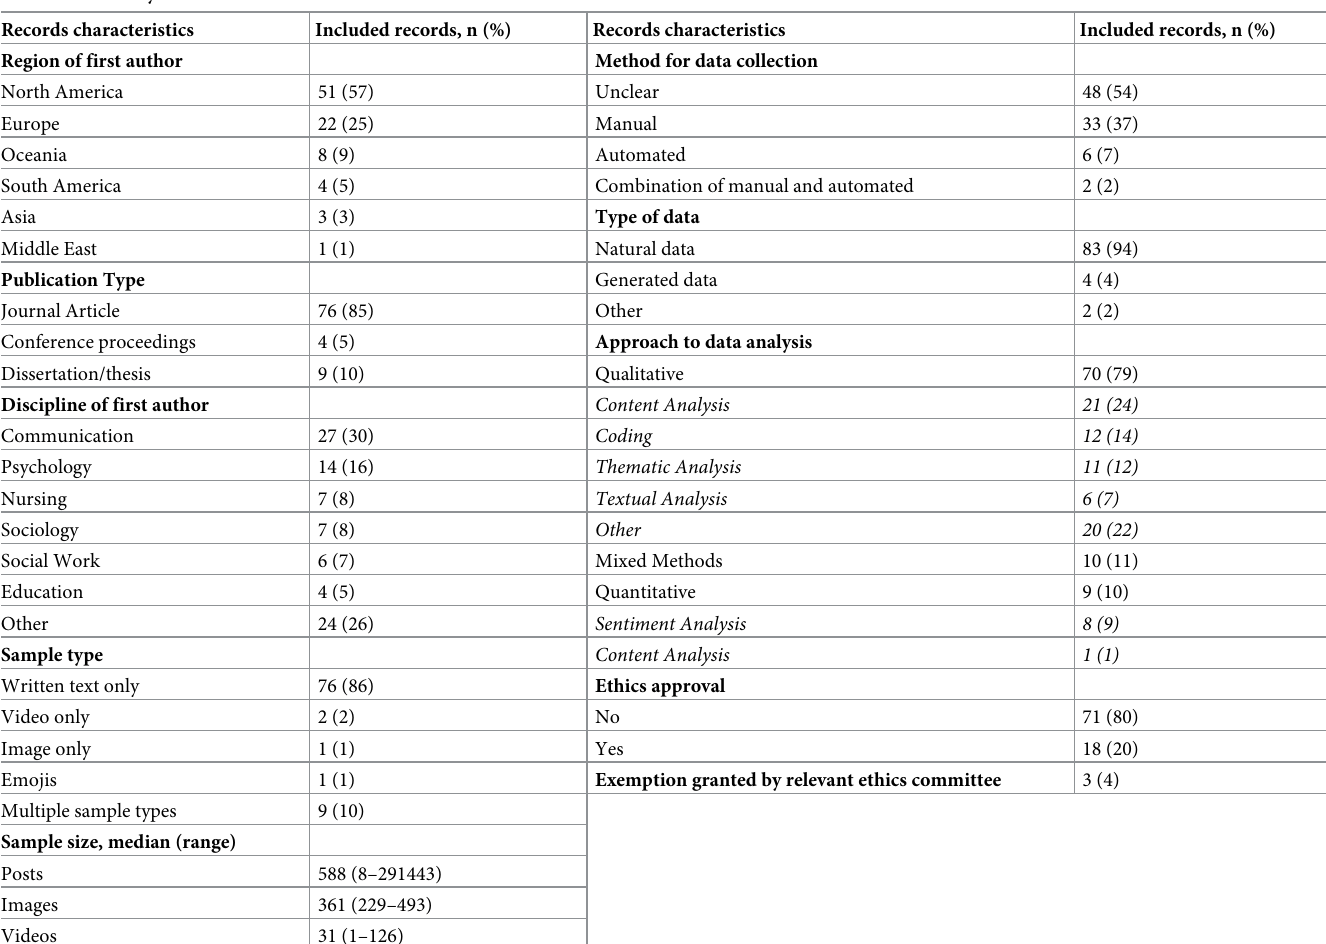
Table 1. Summary of 89 included